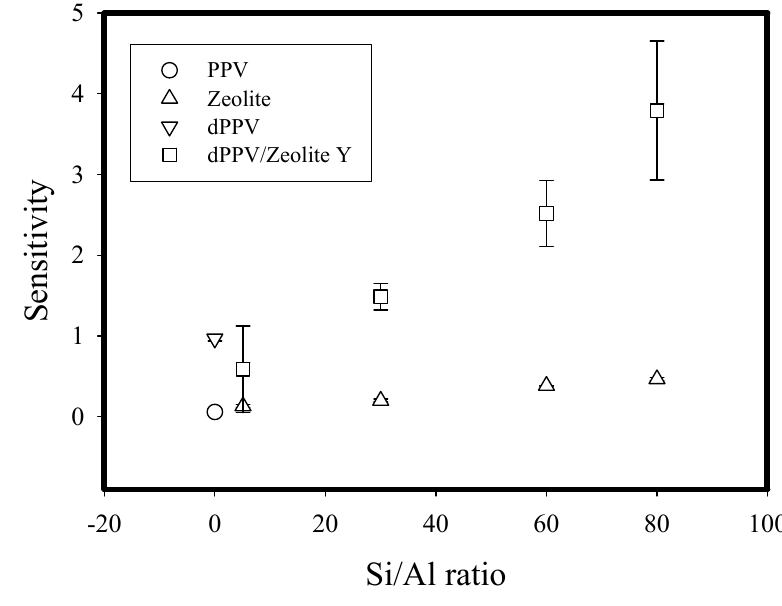
Figure 3. Electrical conductivity sensitivity of PPV, dPPV, Zeolite Y, and dPPV/zeolite Y composites of different Si/Al